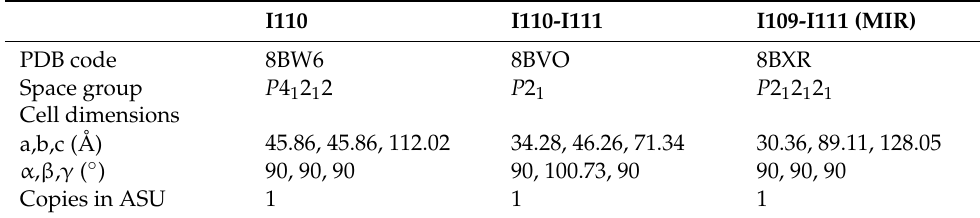
Table 1. X-ray diffraction data and model refinement